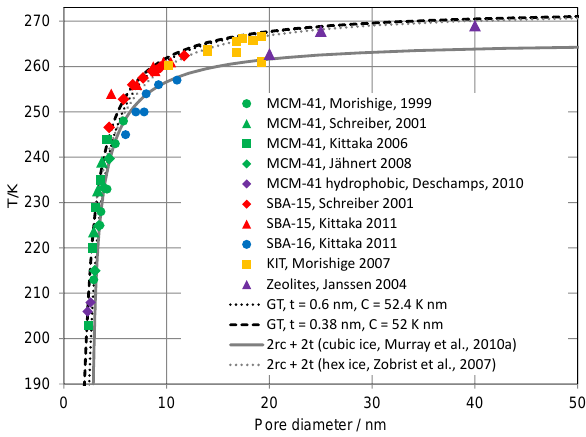
Fig. 2. Ice melting in completely filled pores of different meso- porous materials. Data is taken from Morishige and Kawano (1999) (X-ray diffraction patterns in ca. 2K steps), Schreiber et al. (2001) (DSC curves at 0.5Kmin − 1 , evaluation of peak maxima), Kittaka et al. (2006) (DSC curves at 5 Kmin − 1 , evaluation of peak on- set), Jähnert et al. (2008) (DSC curves at 0.5Kmin − 1 , evaluation of peak maxima), Deschamps et al. (2010) (DSC curves of hydropho- bic pores at 0.5Kmin − 1 , evaluation of peak maxima), Kittaka et al. (2011) (DSC curves at 5Kmin − 1 , evaluation of peak onset), Morishige et al. (2007) (DSC curves at 0.5Kmin − 1 , evaluation of peak onset), and Janssen et al. (2004) (DSC curves at 0.5Kmin − 1 , evaluation of peak onset). Black dashed and dotted lines: melting point depression from the Gibbs–Thomson equation (GT). Grey dotted and solid lines: pore diameter needed to incorporate a critical cluster of hexagonal (calculated with values from parameterization by Zobrist et al., 2007) and cubic ice (calculated with values from parameterization by Murray et al., 2010a),